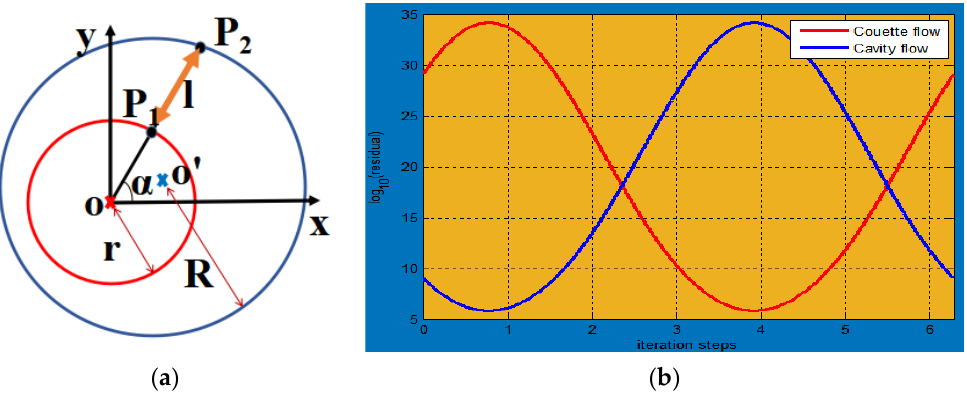
Figure 3. Schematic representation of the eccentric image acquisition model: ( a ) eccentric position acquisition model and ( b ) the shortest distance change curve of various directions.